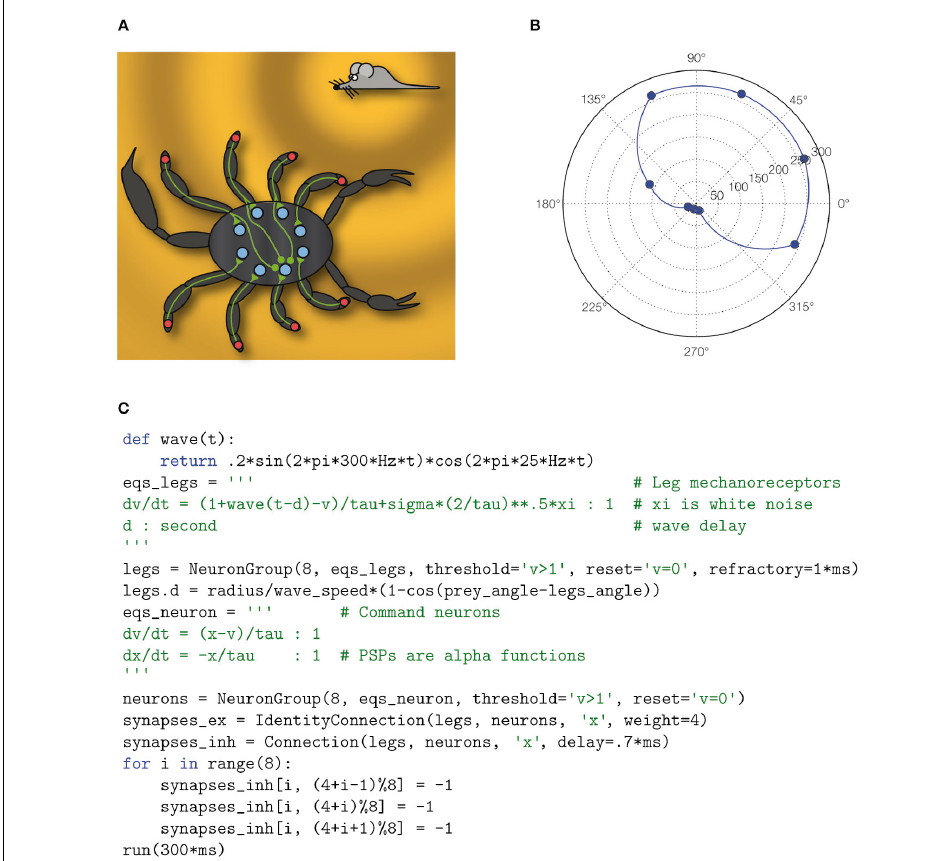
Figure 2 | Brian implementation of a model of prey localisation in the sand scorpion, adapted from Stürzl et al. (2000). The movement of the prey causes a surface wave [function wave in the code in panel (C) ] which is detected by mechanoreceptors [the red points in panel (A) ] at the ends of each of the scorpion’s legs. The mechanoreceptors are modelled by noisy, leaky integrate-and-fi re neurons with an input current defi ned by the surface wave displacement at the ends of the legs (object legs in the code, defi ned by the equations eqs_legs . These neurons send an excitatory signal (the object synapses_ex ) to corresponding command neurons (the blue points) modelled by leaky integrate-and- fi re neurons (object neurons with equations eqs_neuron ), which also receive delayed inhibitory signals (the object synapses_inh ) from the three legs on the other side (the for loop). A wave arriving fi rst at one side of the scorpion will cause an excitatory signal to be sent to the command neurons on that side causing them to fi re, and an inhibitory signal to the command neurons on the other side, stopping them from fi ring when the wave reaches the other side. The result is that command neurons are associated to the directions of the corresponding legs, fi ring at a high rate if the prey is in that direction. Panel (B) shows the fi ring rates for the eight command neurons in a polar plot for a prey at an angle of 60 degrees relative to the